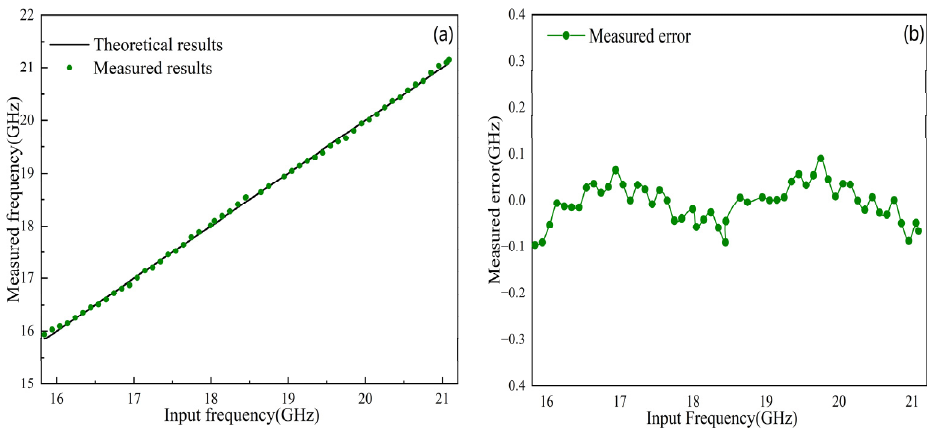
Figure 7. ( a ) Theoretical and measured results of frequency measurements. ( b ) measurement error.